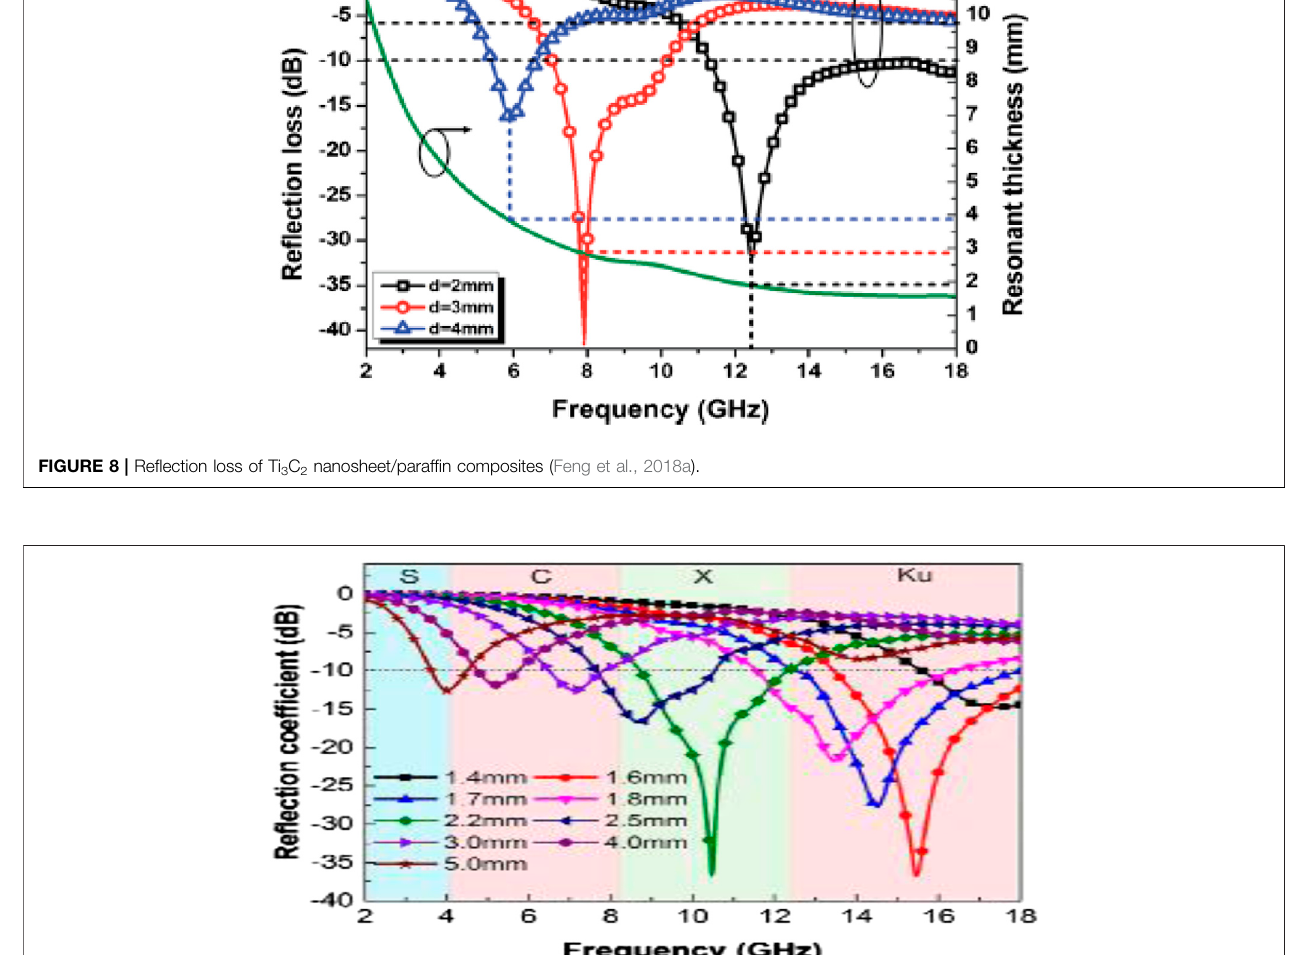
Frontiers in Materials |